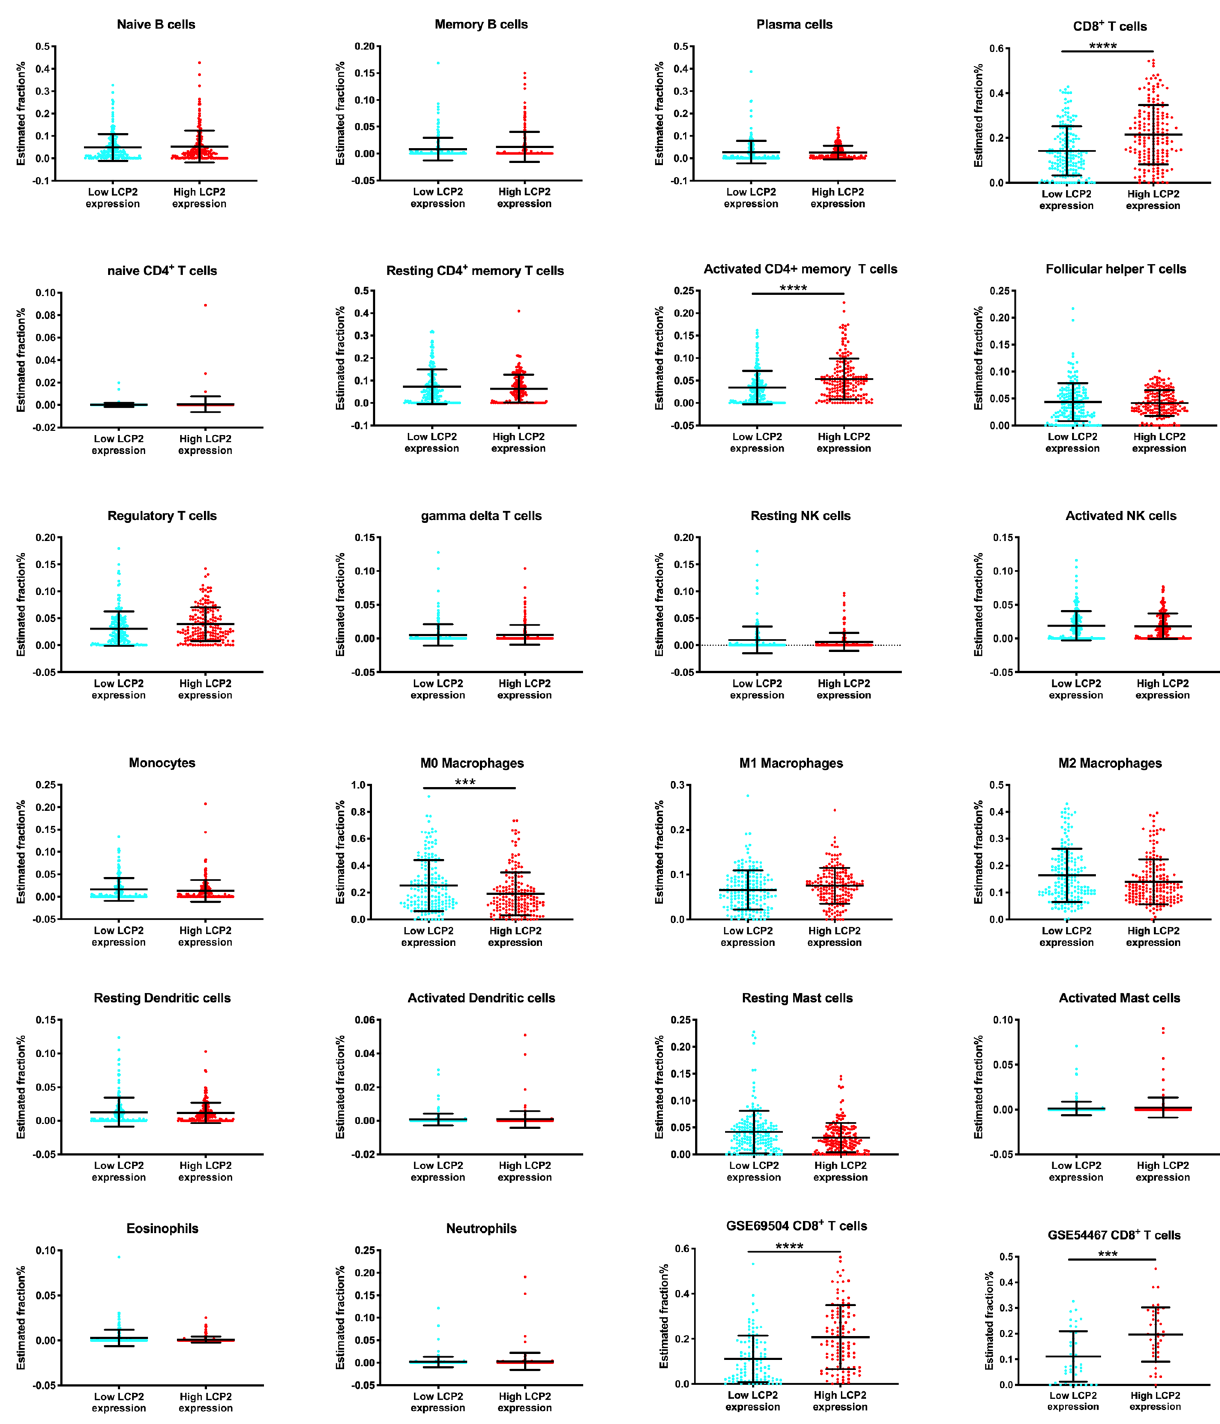
Figure 8. CIBERSORT analysis of 22 immune cells based on LCP2 expression level. Significantly higher estimated fractions of CD8 + T cells and activated memory CD4 + T cells occurred in the high- LCP2 expression group, whereas lower estimated fractions of M0 macrophages existed in the high- LCP2 expression group. Validation cohorts (GSE65904 and GSE54467) indicated that significantly higher estimated fractions of CD8 + T cells occurred in the high- LCP2 expression